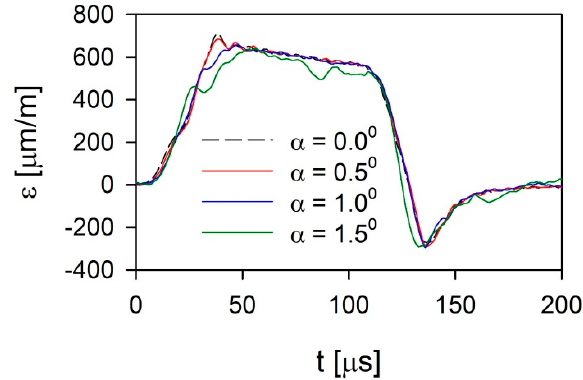
Figure 7. Reflected disturbed pulses for SHPB using a pulse shaper for an imperfection in the form of inclination angle α between the striker and input bar.